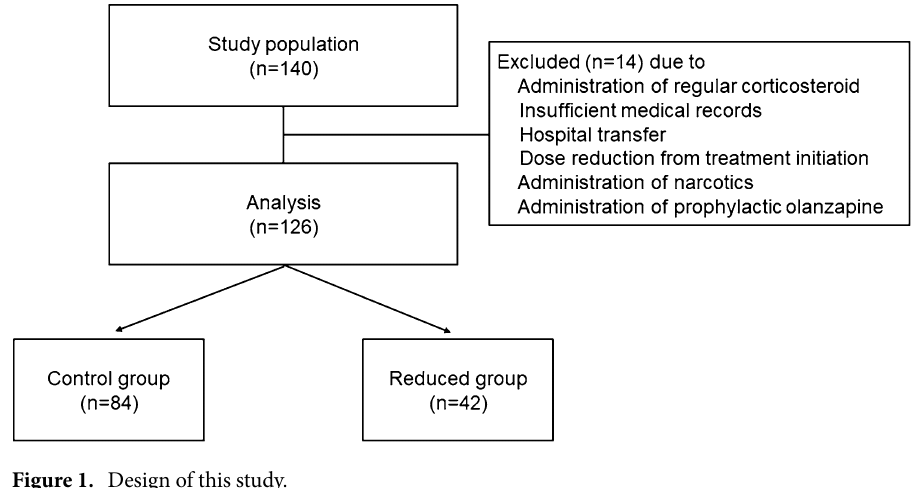
Figure 1. Design of this